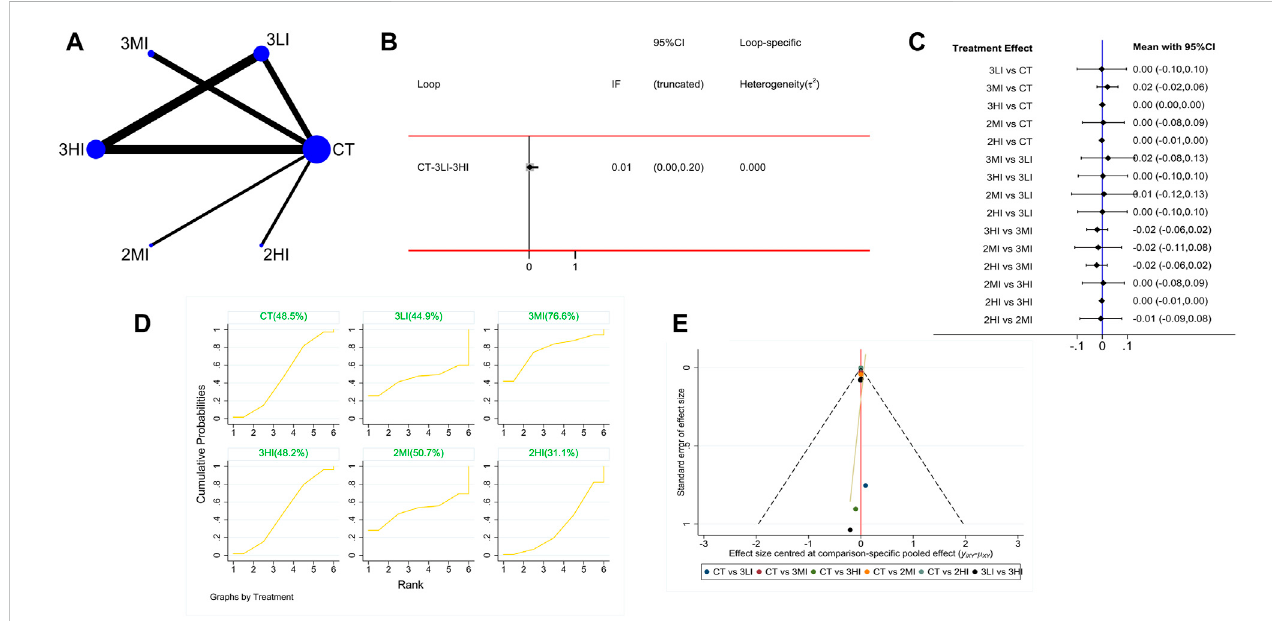
FIGURE 4 Network meta-analysis results for total hip (TH) BMD. (A) Network evidence diagram; (B) loop inconsistency test; (C) forest plot; (D) the fi gure of cumulative probability ranking; (E) funnel